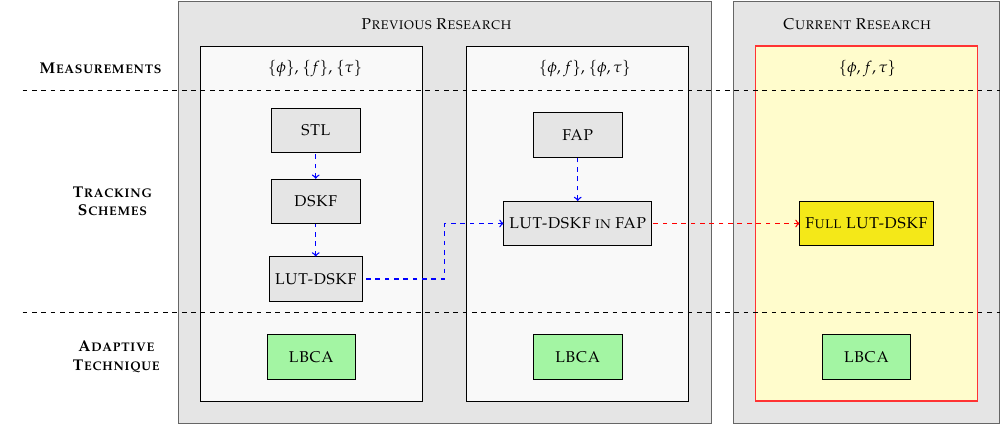
Figure 1. Research survey and comparison to other